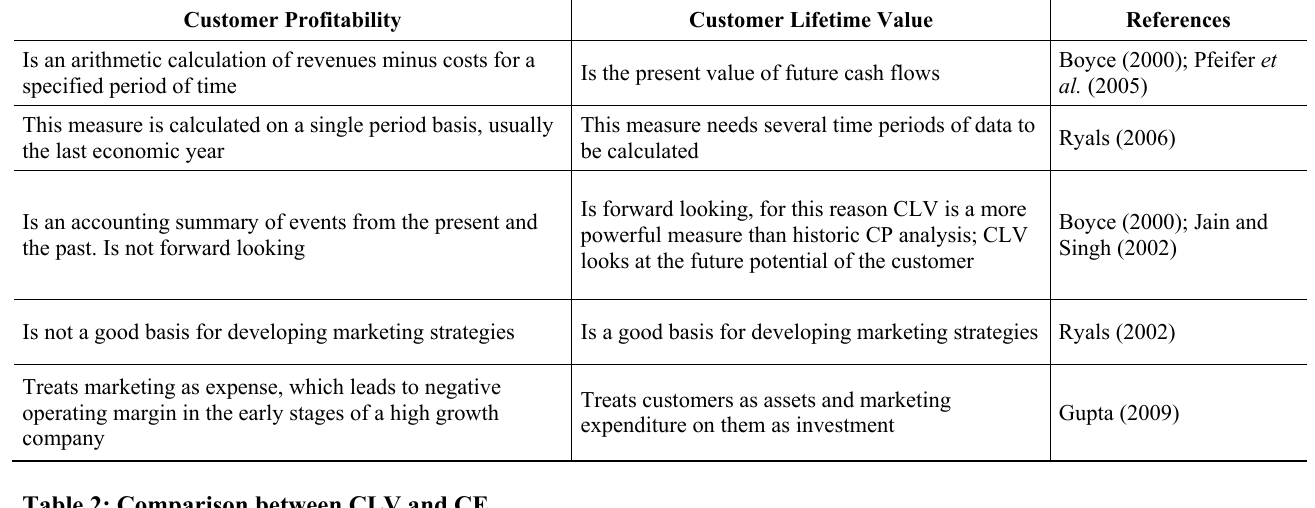
Table 1: Comparison between CP and CLV